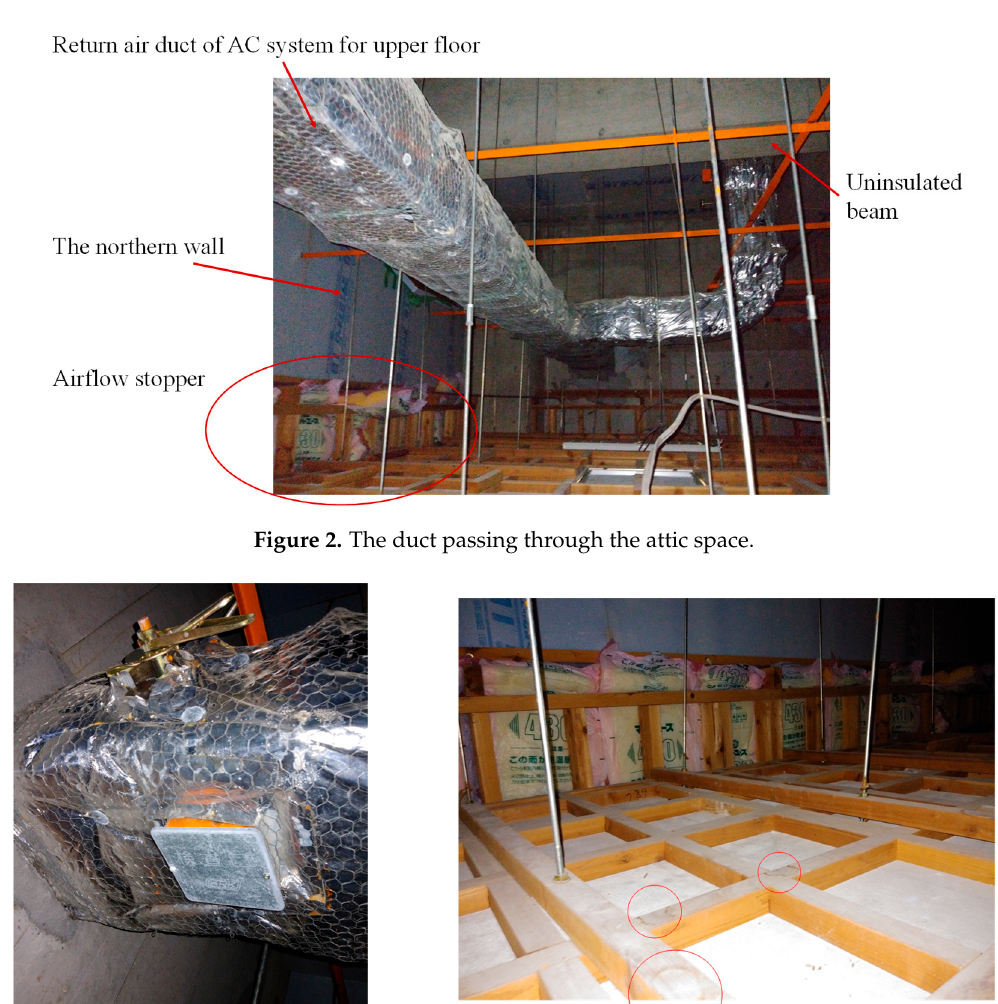
Figure 1. Floor plan around the storage room.